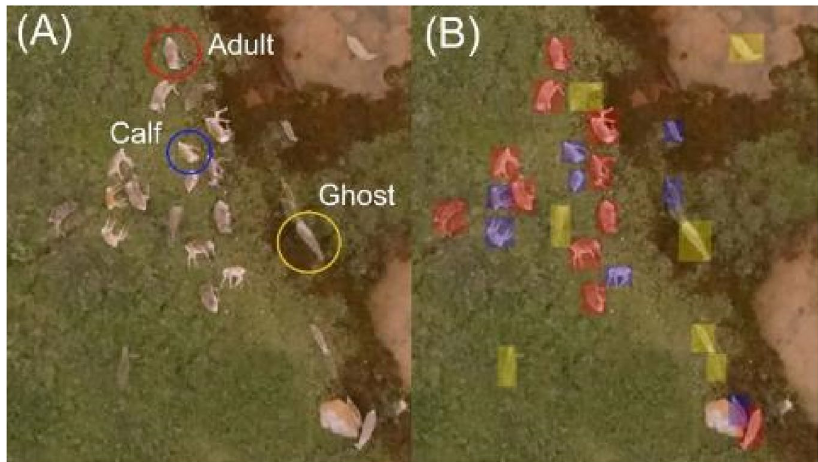
Figure 1. ( A ) Examples of adult (red circle), calf (blue circle), and ghost (yellow circle) caribou that observers classified at the Open UAS Repository—OUR (https:// digit alag. org/ our/). ( B ) Adults (red rectangles), calves (blue rectangles), and ghosts (yellow rectangles) after the classification in the repository. Figure was assembled using Affinity Designer v 1.9.1.979 (https:// affin ity. serif.